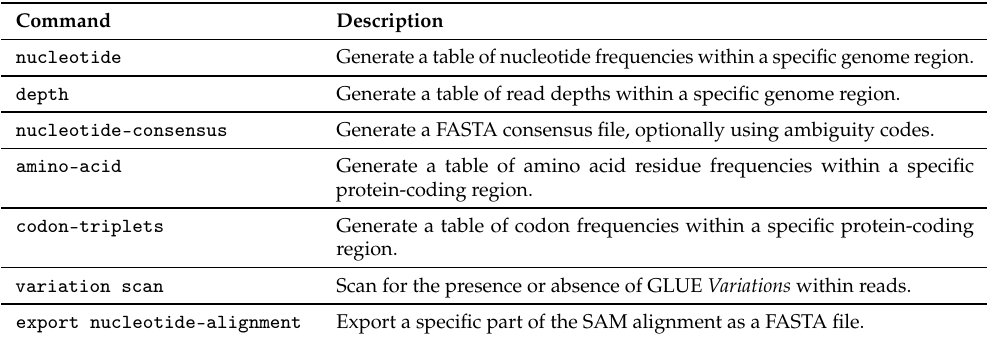
Figure 1. The chain of pairwise homology relationships between reads and the master reference sequence (H77 for HCV), established during the operation of GLUE samReporter. Table 2. GLUE samReporter